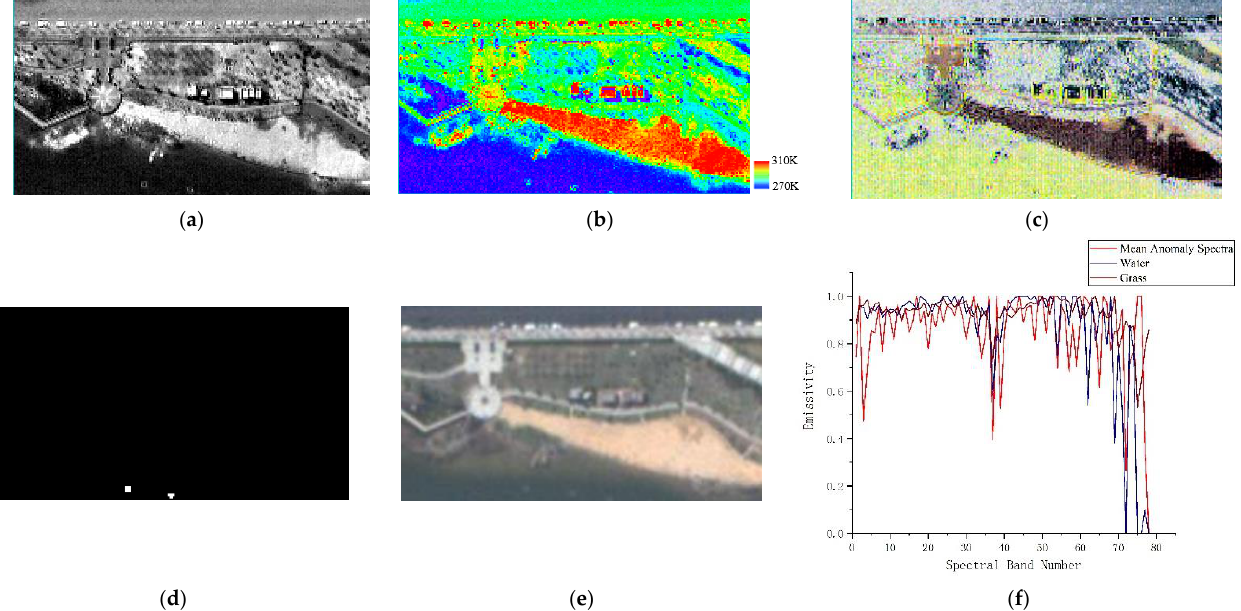
Figure 9. Buoys data set. ( a ) Radiance domain. ( b ) Temperature image; ( c ) emissivity RGB pseudo-color image synthesized by band 8, 11, 25; ( d ) ground-truth map; ( e ) RGB image; and ( f ) emissivity spectral signatures of anomalies and background. After AC and TES, the radiance image and temperature image were used to generate homogeneous regions. Figure 10 shows the segmentation map.